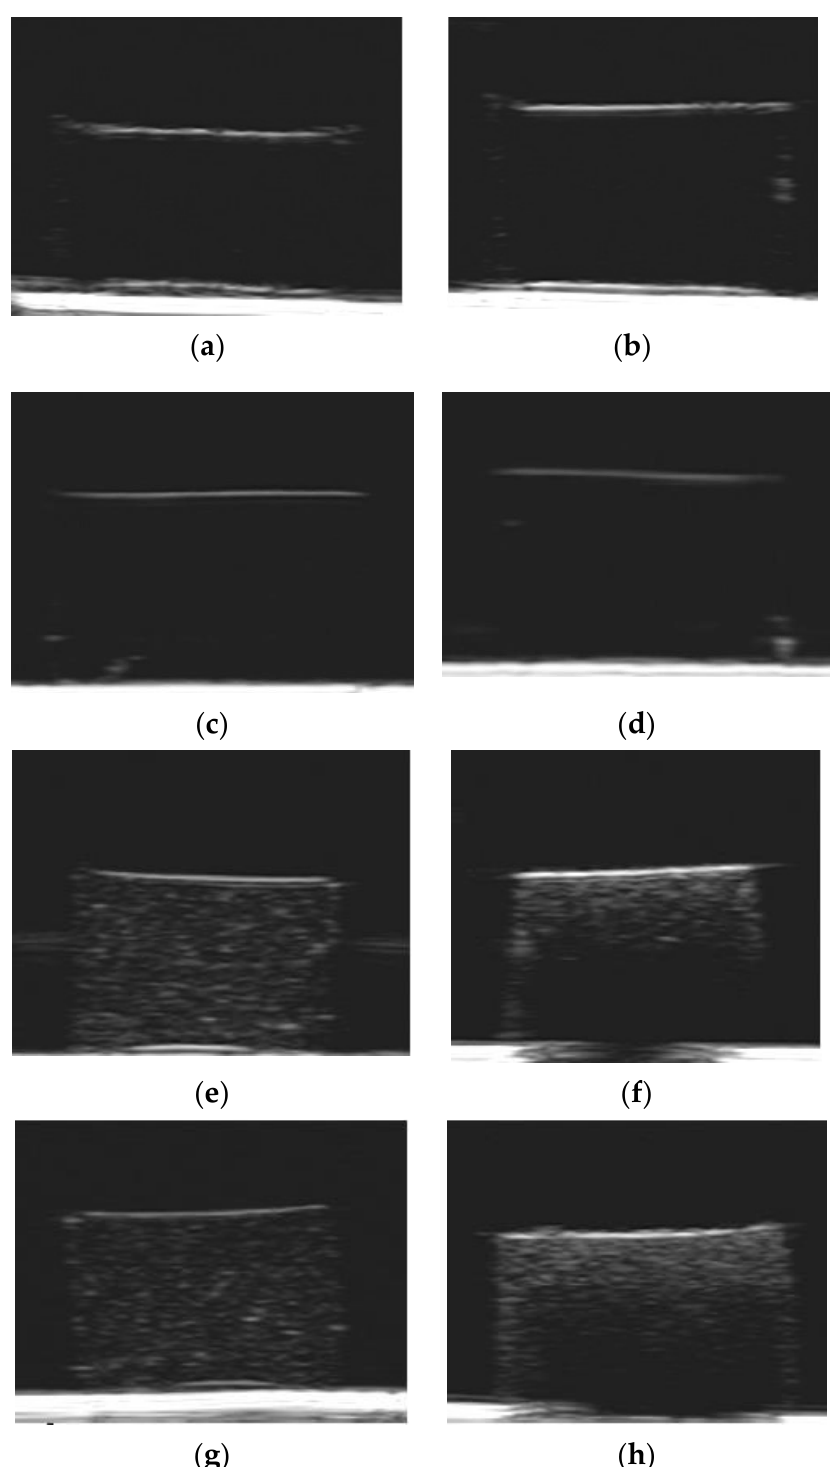
( b ) Figure 6. Dependences of storage modulus (G') and loss modulus (G'') on the MPs concentration for samples PAAm/Xanthan ( a ) and PAAm/Guar ( b ). Vertical bars reflect the confidence interval with p = 0.01 ( n = 5). Equations of linear regression are: ( a ) y = 0.15x + 1.60 (R 2 = 0.973) for G' and y = 0.01x + 0.11 (R 2 = 0.85) for G''; ( b ) y = 0.11x + 2.81 (R 2 = 0.98) for G' and y = 0.01x + 0.26 (R 2 = 0.95) for G''. Thus, the addition of iron oxide MPs to the gel network resulted in the increase of elasticity in composites based on PAAm and polysaccharides. Moreover, the effect of MPs concentration on the FGs viscoelastic properties was approximately the same in two tested series of ferrogels. 3.3. Effect of MPs Concentration on FGs Echogenicity Figure 7 demonstrates some examples of FGs visualization obtained in both the series of ferrogels filled with iron oxide MPs (e, f, g, h). The ultrasound images for blank PAAm gel (a), for PAAm ferrogel filled with iron oxide magnetic nanoparticles (b), for blank PAAm/Xanthan gel (c) and for blank PAAm/Guar gel (d) are also presented for compari- son. One can see that the boundary of gel/water was clearly visualized in all presented samples. At the same time, the echogenicity inside the blank PAAm gel (a), ferrogel with magnetic nanoparticles (b) and blank gels with interpenetrating polymer networks (c, d) did not differ from the background (water).